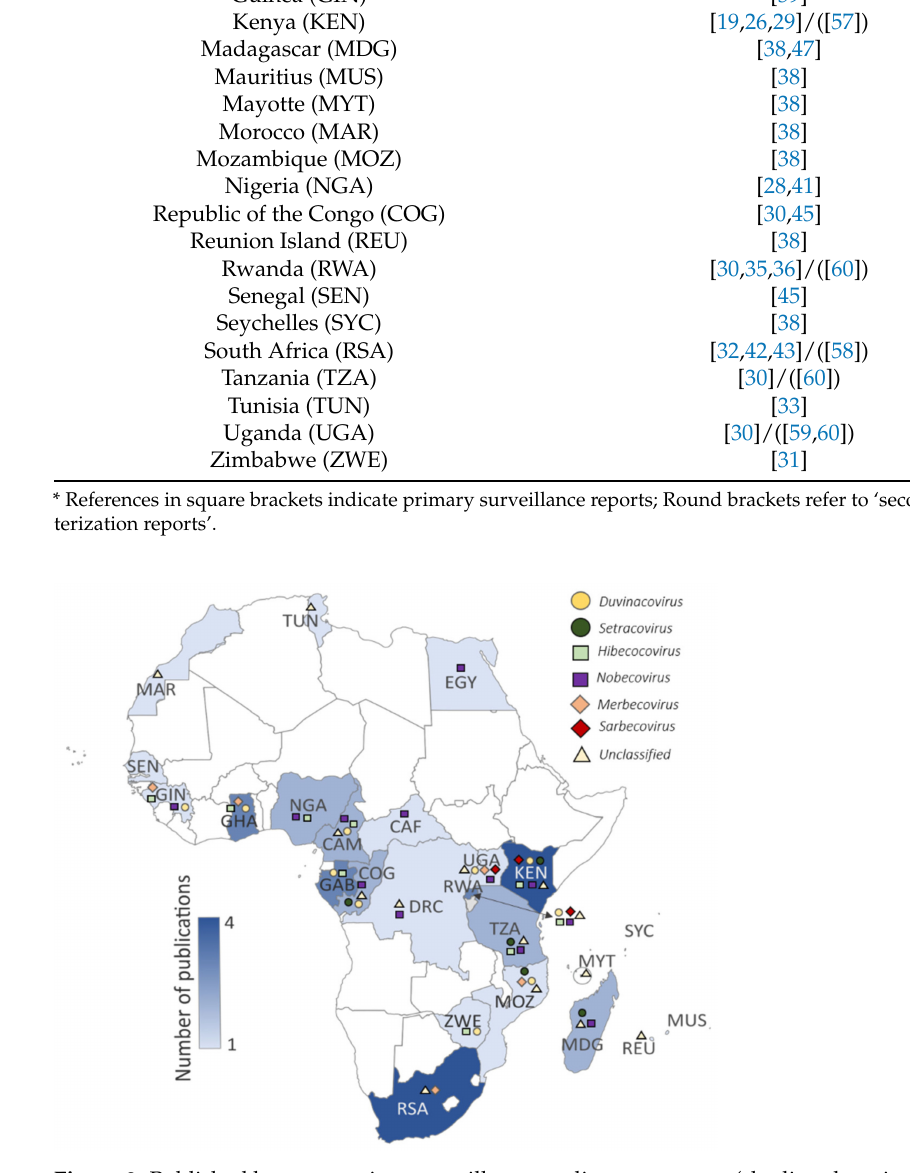
Figure 2. Published bat coronavirus surveillance studies per country (shading denoting the number of publications). Symbols in the key above the map represent different coronaviruses detected in the respective countries: Duvinacovirus as a yellow circle (HCoV229E-related viruses), Setracoronavirus as a dark green circle (HCoVNL63-related viruses), Sarbecoviruses as a red diamond (HCoV-SARS- related viruses), Merbecoviruses as an orange diamond (HCoV-MERS-related viruses), Nobecoviruses as a purple square, Hibecoviruses as a green square, and unclassified viruses as a black triangle. Further details on coronaviruses identified can be reviewed in Table S4. Three-letter ISO country code abbreviations are shown on the